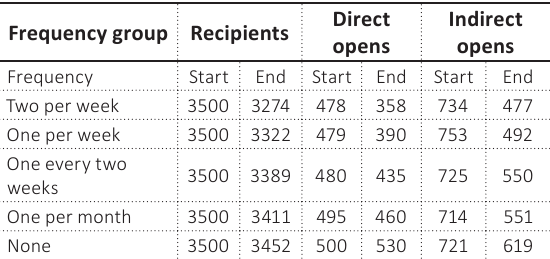
Table 1. Start-end-comparison of recipients, direct opens and indirect opens per frequency group